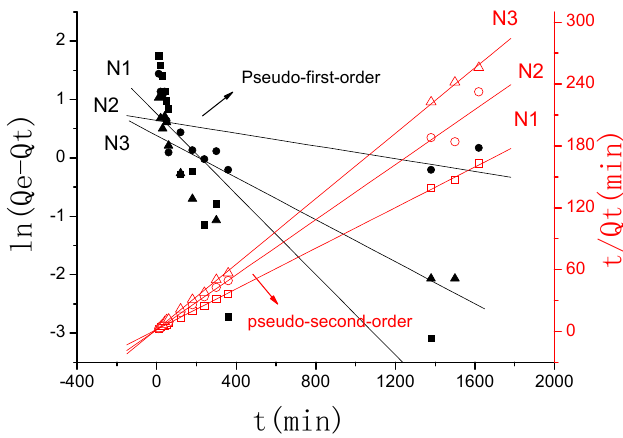
Figure 9. The swelling kinetics of γ -PGA/ ε -PL hydrogels in CaCl 2 solution.